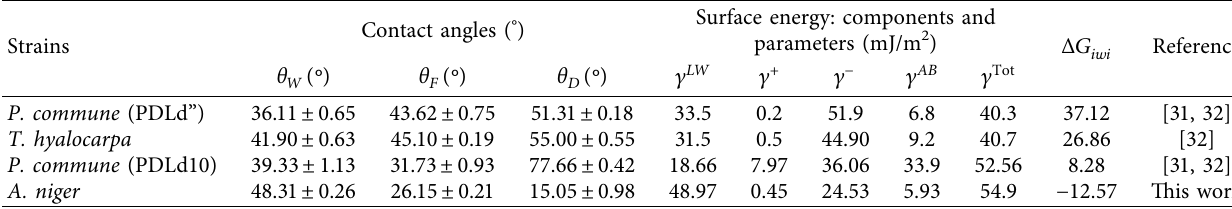
Table 4: Contact angles values, surface energies, and their components for four fungal strains. Strains